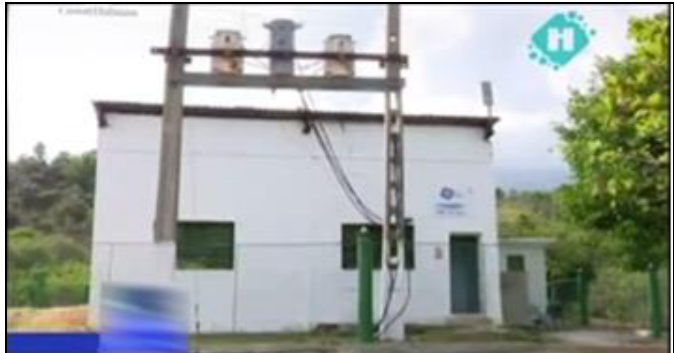
Figura 10: Caseta de la mini hidroeléctrica El Dian (Ocujal del